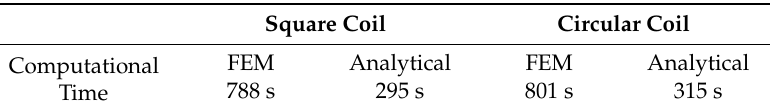
Table 6. Computational times of the FEM and analytical calculations. Square